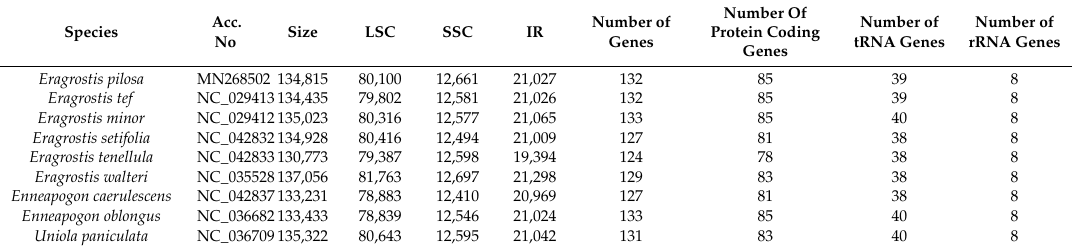
Table 1. Chloroplast genome features of E. pilosa and other Eragrostideae species.